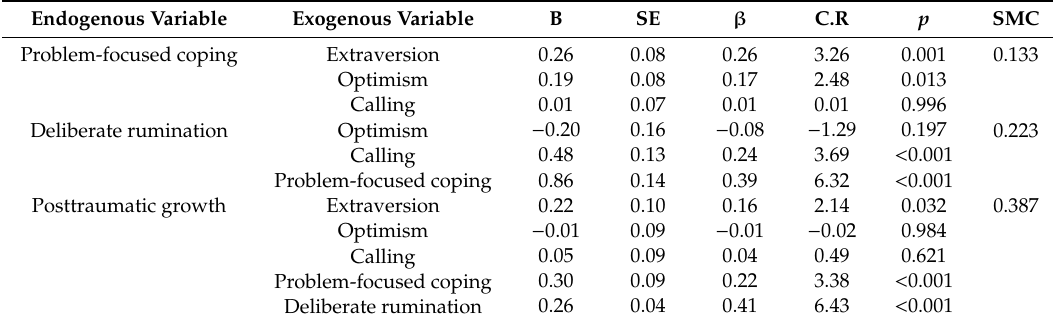
Table 3. Test of the hypothetical model’s e ff